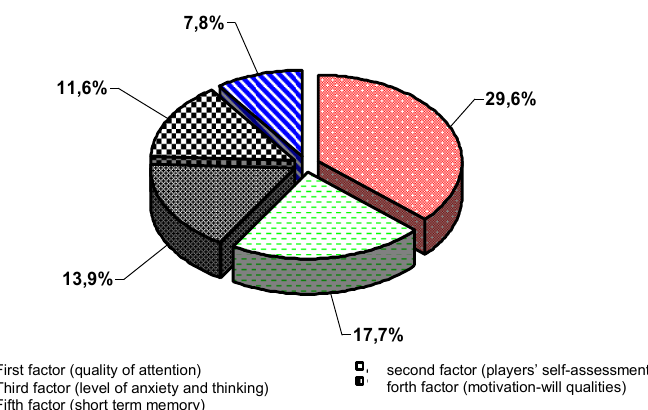
Fig.1. Factorial structure of 14-15 years’ age tennis players’ psychological fitness: